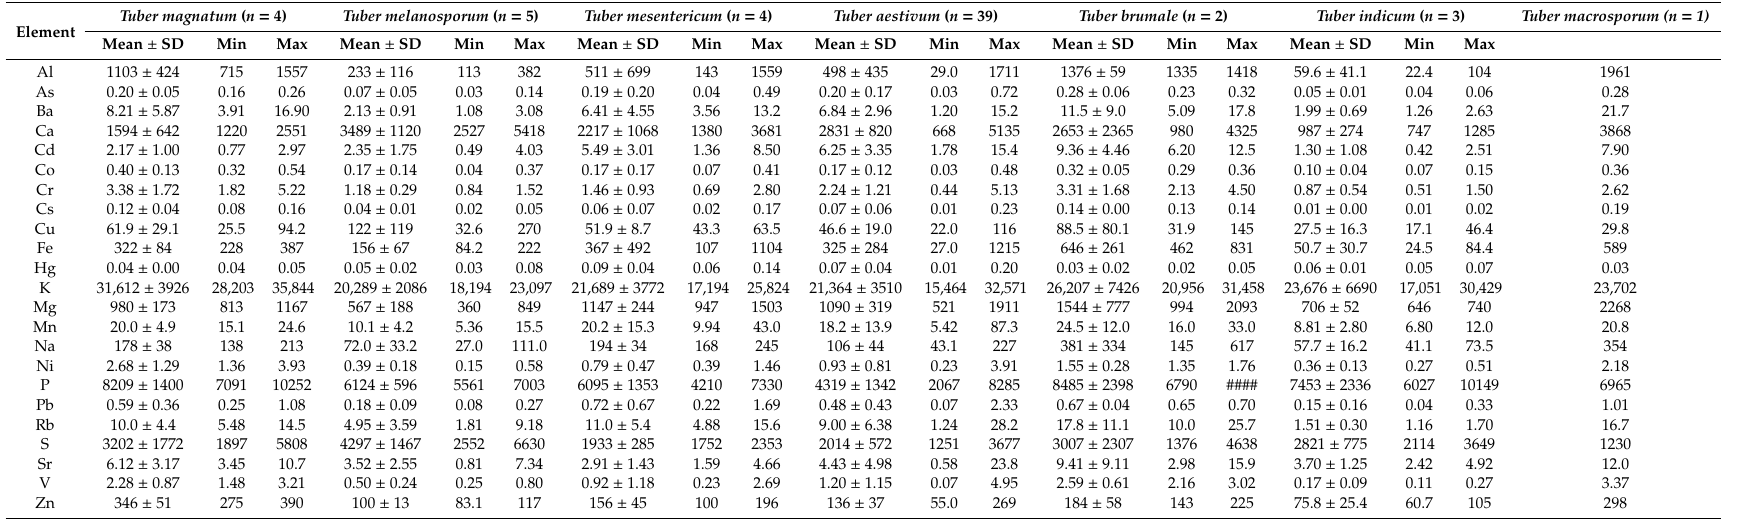
Table 1. Minimum (Min), maximum (Max), and mean concentration (Mean) ± standard deviation (SD) of elements in the peridial layer of the fruiting bodies of di ff erent tru ffl e species. All elements are expressed in mg / kg.